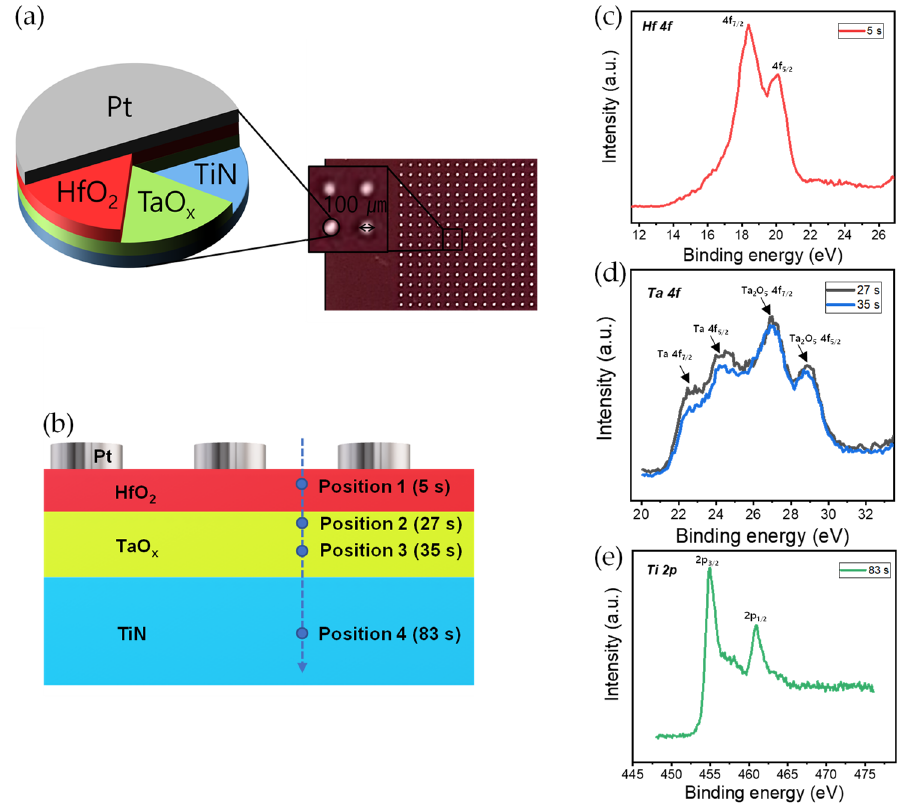
Figure 1. ( a ) Schematic of Pt/HfO 2 /TaO x /TiN device stack and top view of the device; ( b ) cross-section image for XPS depth profile. XPS spectra of ( c ) Hf 4f, ( d ) Ta 4f, and ( e ) Ti 2p.